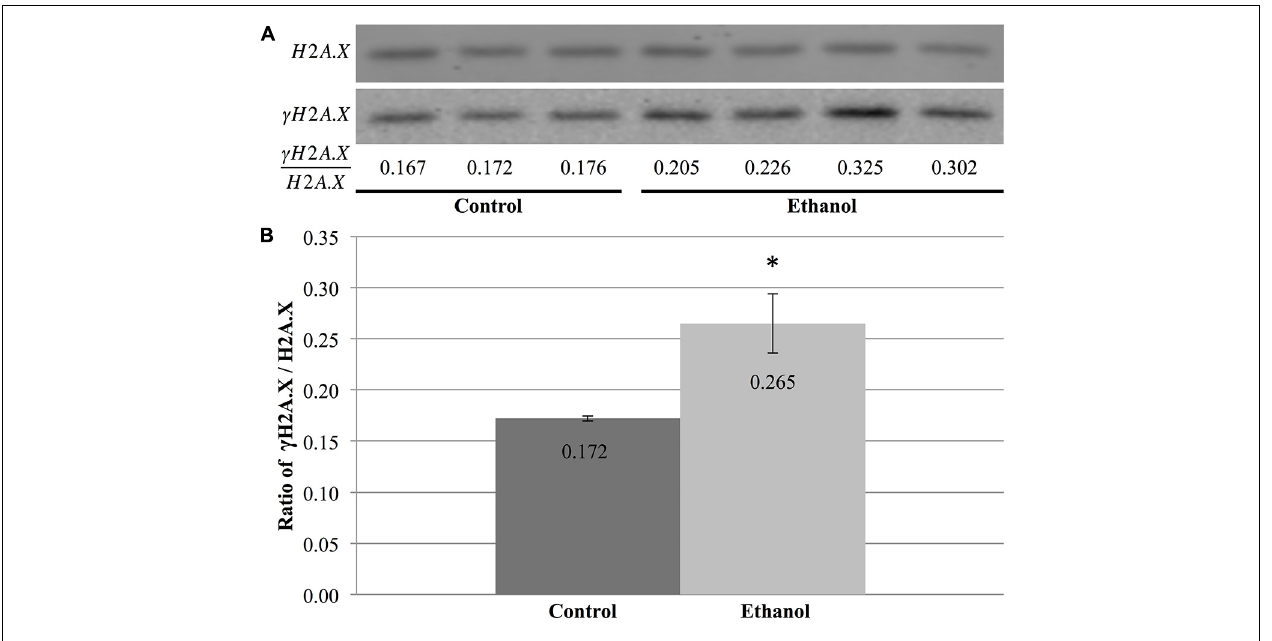
FIGURE 6 | Ethanol exposure increases levels of γ H2A.X in the cerebral cortex. (A) Protein blot analysis was performed on nuclear histones isolated from the cerebral cortex of three control and four ethanol male P7 mice. H2A.X levels were used as a loading control to